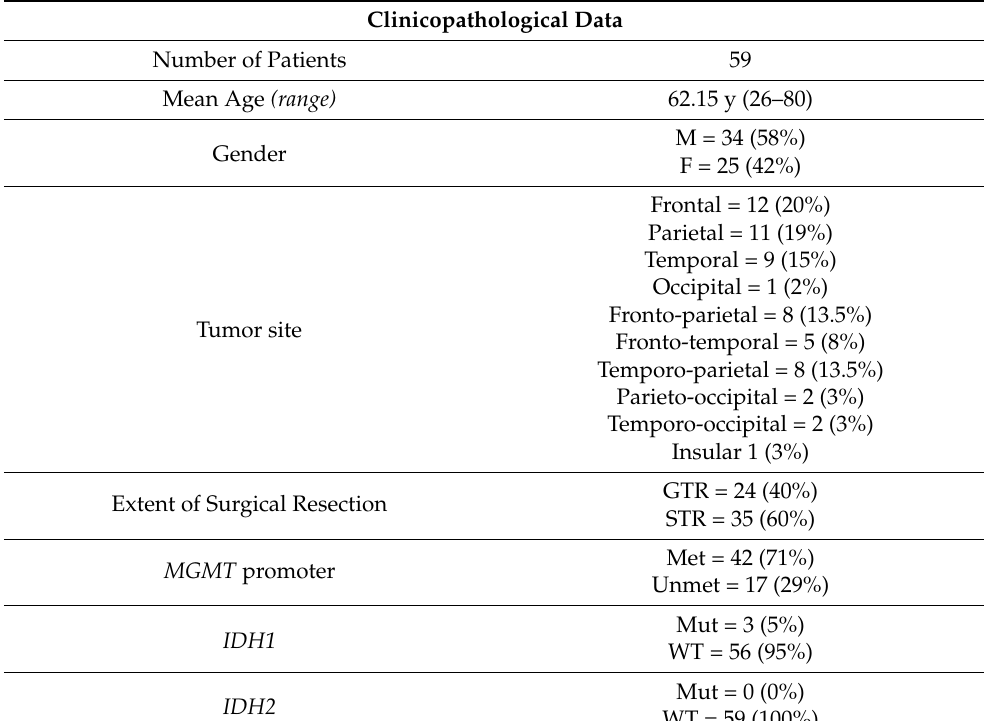
Table 1. Clinicopathological